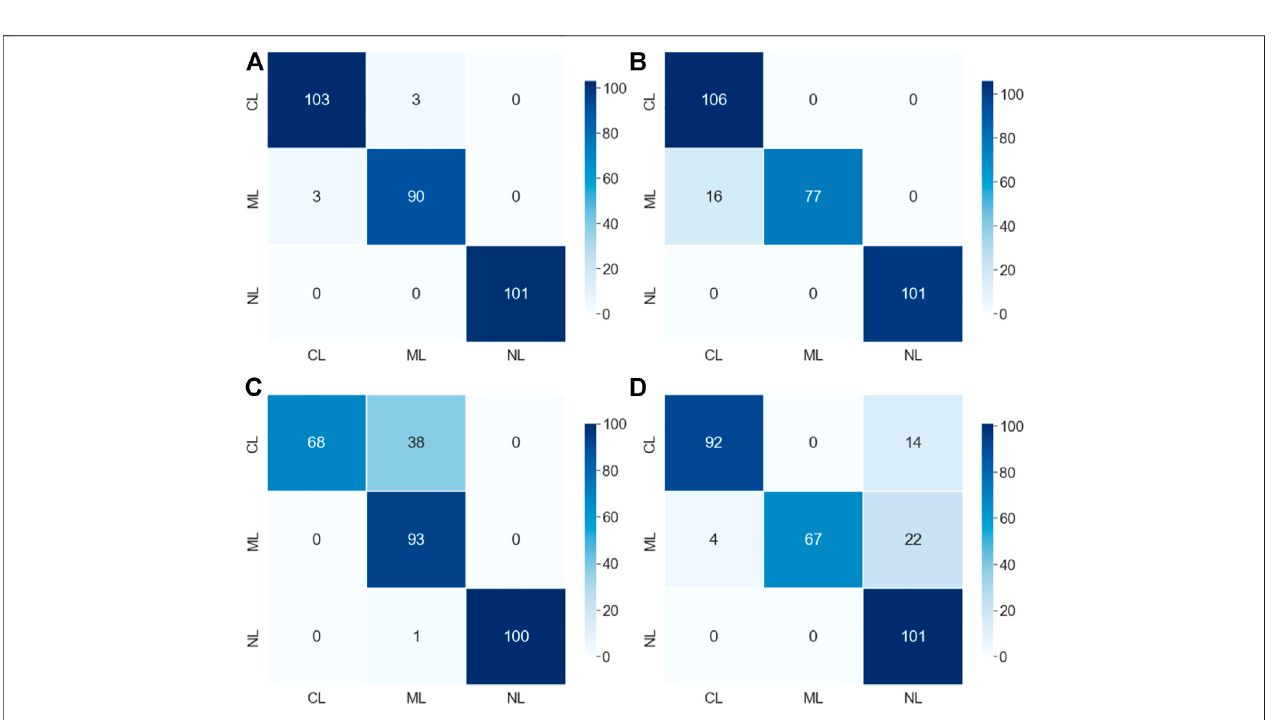
FIGURE 5 | Confusion matrix charts of the seal state identi fi cation results obtained by different CNN models. (A) VGG16, (B) NIN, (C) GooLeNet, (D) ResNet50.